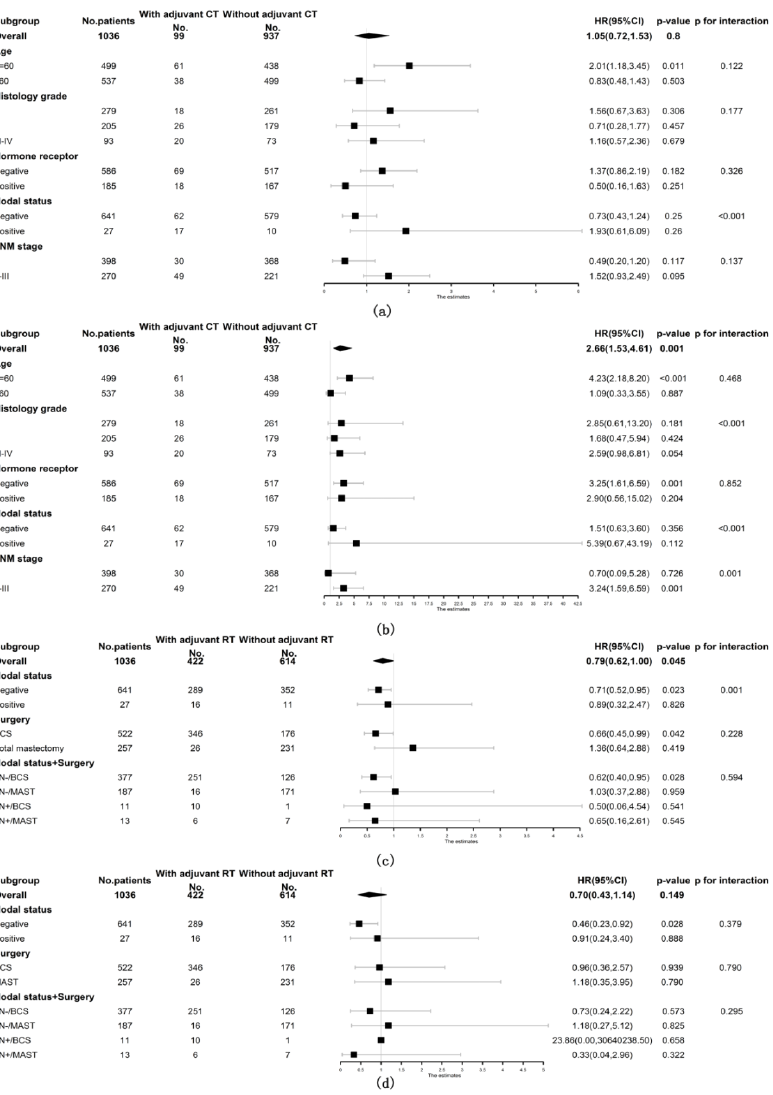
Figure 3. Forest plots of interaction and univariate subgroup analyses on the association between adjuvant treatments and survival of patients with ACC of the breast. The association between adju- vant chemotherapy and ( a ) OS and ( b ) BCSS of patients with ACC of the breast. The association between adjuvant radiotherapy and ( c ) OS and ( d ) BCSS of patients with ACC of the breast. Abbre- viations: ACC = adenoid cystic carcinoma of the breast; BCS = breast conserving surgery; BCSS = breast cancer-specific survival; CT = chemotherapy; HR = hazard risk; LN- = lymph node negative;